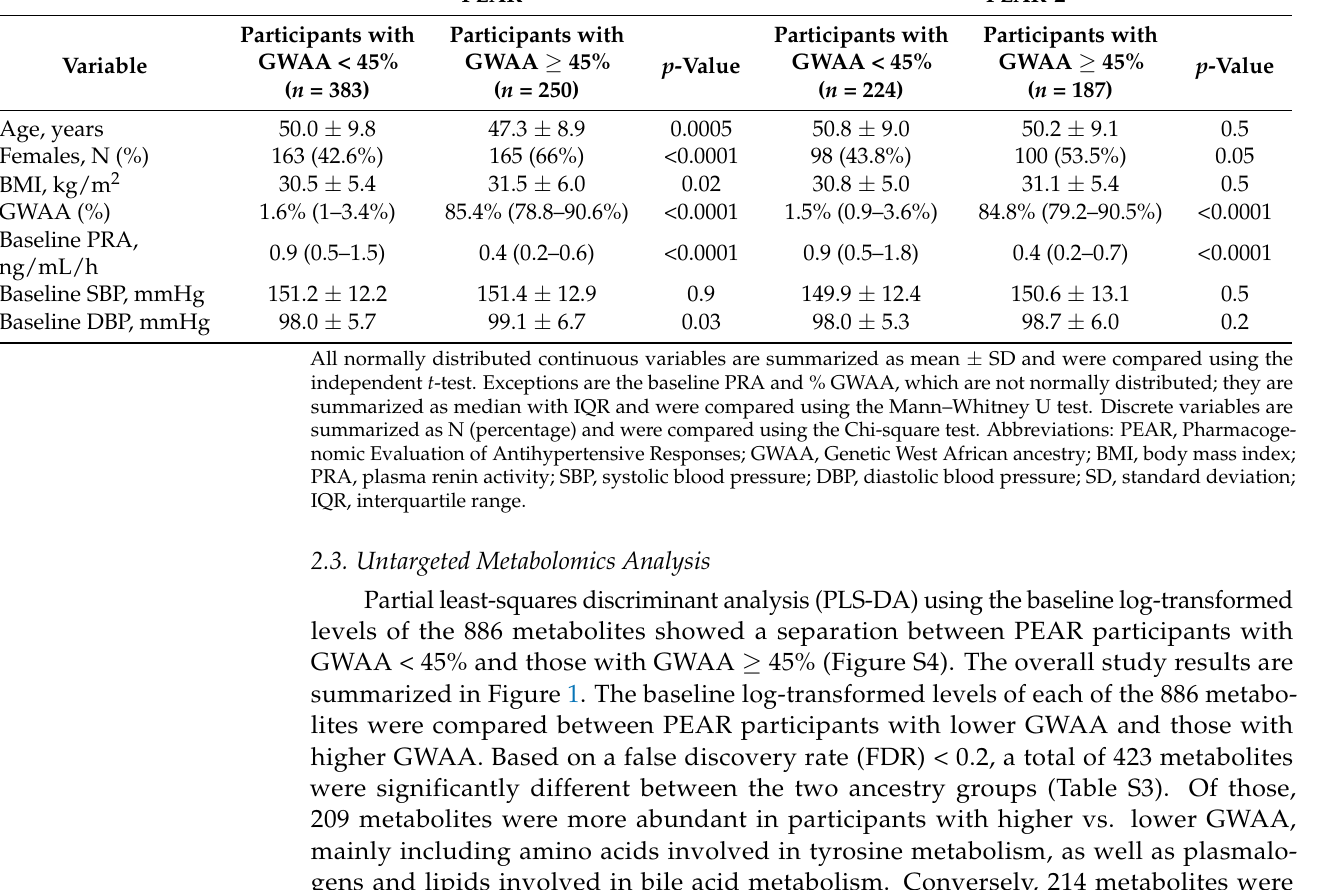
Table 1. Baseline characteristics of participants included from PEAR and PEAR-2 studies. PEAR